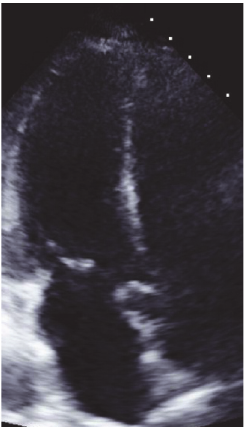
Figure 7: Resolution of SIC, end systole ( SIC resolution pics).